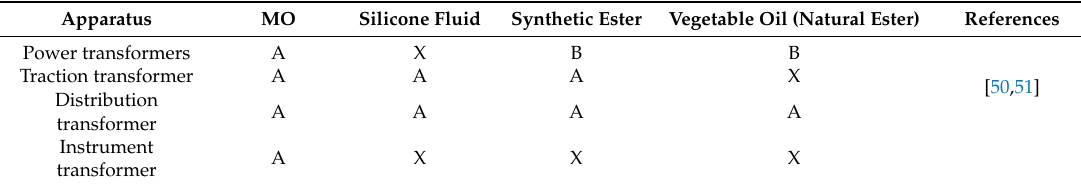
Table 20. Use of di ff erent insulating fluids in